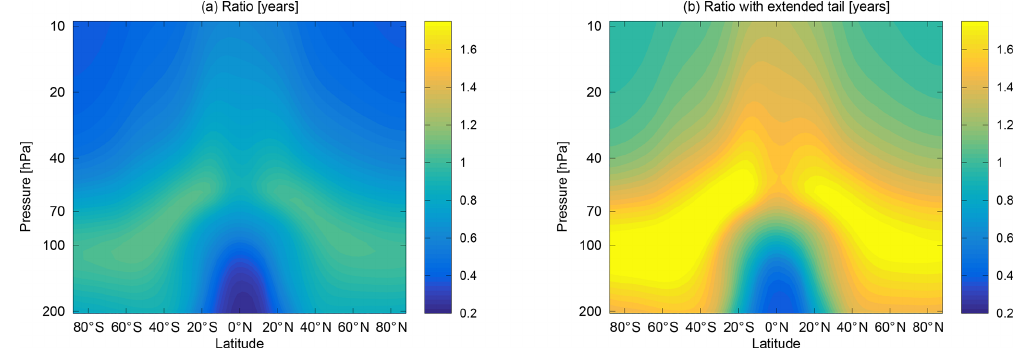
Figure 6. Mean ratio (cid:49) 2 derived from age spectra in the tranPul simulation. (a) For the regular 9.5-year long spectra; (b) with an exponen- (cid:48) tially extended tail as in Ploeger and Birner (2016).